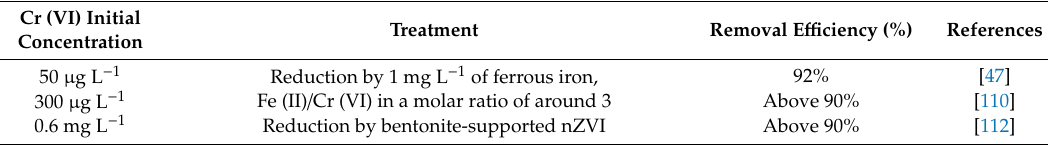
Table 5. E ffi ciency rate of some chemical and biological strategies reported in the recent literature. Cr (VI) Initial